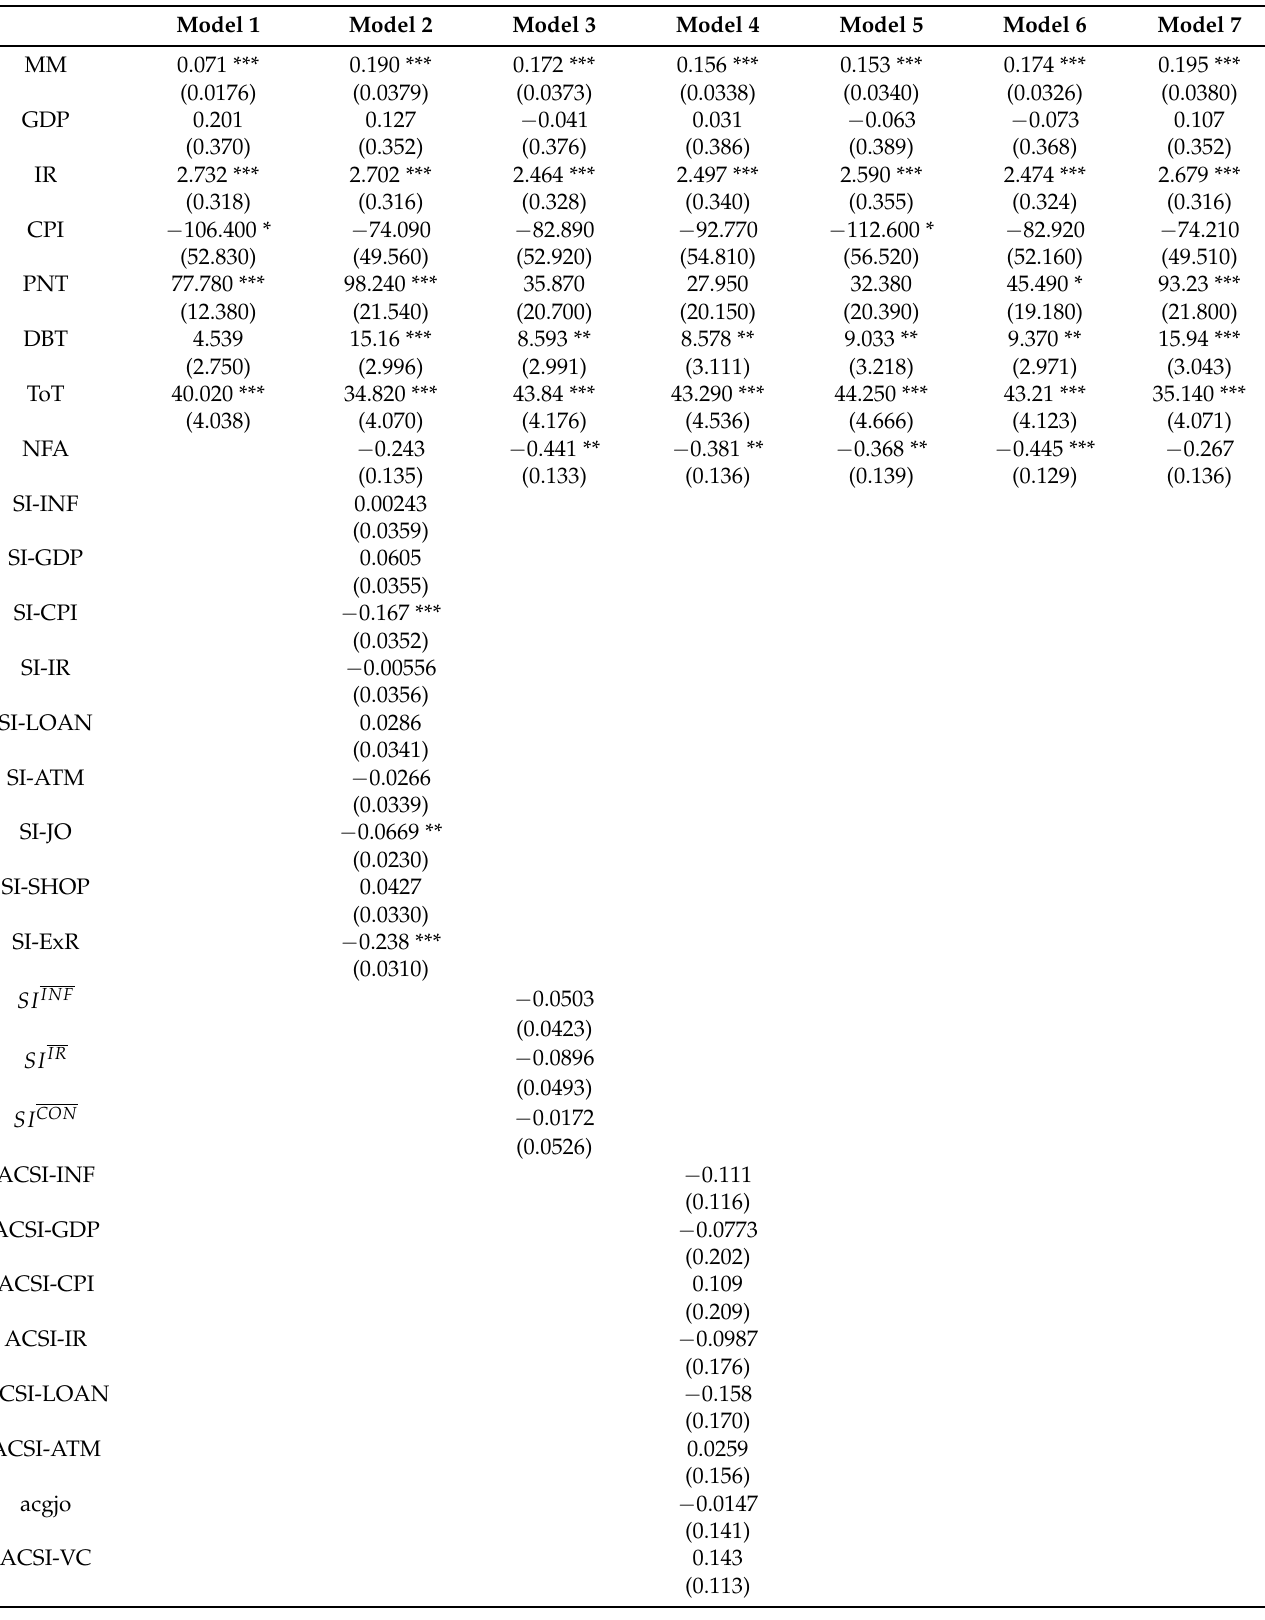
Table 2. Panel Regression Table Random-Effects AM